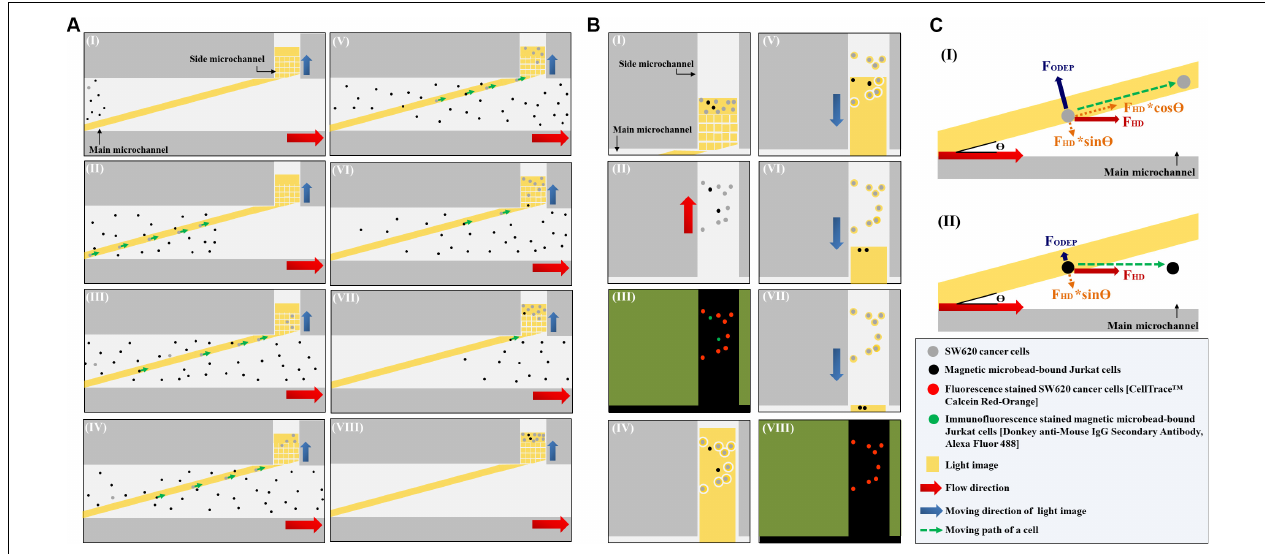
FIGURE 2 | Schematic presentation (top view) of the working mechanism for the continuous isolation and purification of cancer cells from the magnetic microbead-bound Jurkat cells; (A) the first step ODEP cell manipulation process: (I): a static rectangular light bar (L: 3.9 mm, W: 100 µ m) with a particular angle (e.g., 15 ◦ ) to the flow direction of the cell suspension was designed at the defined cell isolation zone of the main microchannel, (I–VIII): most of the magnetic microbead-bound Jurkat cells (black dots) in the sample flow were not trapped by the light bar and thus flowed to the downstream of the main microchannel, whereas most of the SW620 cancer cells (gray dots) flowing through the main microchannel were trapped by the light bar and then delivered along the light bar to the side microchannel for cell collection (indicated by arrows), (B) the second step of the ODEP cell manipulation process: (I) a certain amount of the cancer cells were collected in the side microchannel, (II) the liquid flow in the side microchannel was driven to flux the cells collected so that they were evenly spread within the side microchannel, (III) fluorescence microscopy observation was carried out to identify the species of the cells [i.e., fluorescence stained SW620 cancer cells (the red dots) and immunofluorescence stained magnetic microbead-bound Jurkat cells (the green dots)] collected in the side microchannel for positioning the SW620 cancer cells, (IV) static circular light images were illuminated on each SW620 cancer cell. Meanwhile, the side microchannel was projected with a rectangular light bar to manipulate the magnetic microbead-bound Jurkat cells into the side microchannel, in which O-ring-like non-illuminated patterns were designed as partitions to separate the light-illuminated SW620 cancer cells and the other cells, (V–VII) the rectangular light bar on the side microchannel was then moved to manipulate the magnetic microbead-bound Jurkat cells to remove them from the side microchannel, and this process was repeated for 5 times, (VIII) through the previous process, the cell purity of the SW620 cancer cells in the side microchannel was greatly improved, (C) the working mechanism of using a static rectangular light bar both as a virtual cell filter and a virtual cell track for continuous cancer cell separation and isolation: (I) when the F ODEP (ODEP manipulation force) acting on a cell is greater than the component force of F HD (i.e., F HD ∗ sin (cid:50) , (cid:50) : the angle between the rectangular light bar and the flow direction of the cell suspension), the cell could move along the rectangular light bar, driven by another component force of F HD (i.e., F HD ∗ cos (cid:50) ), (II) when the F ODEP is less than F HD ∗ sin (cid:50) , conversely, a moving cell might not be trapped by the designed light bar image and thus flows through the light image area.